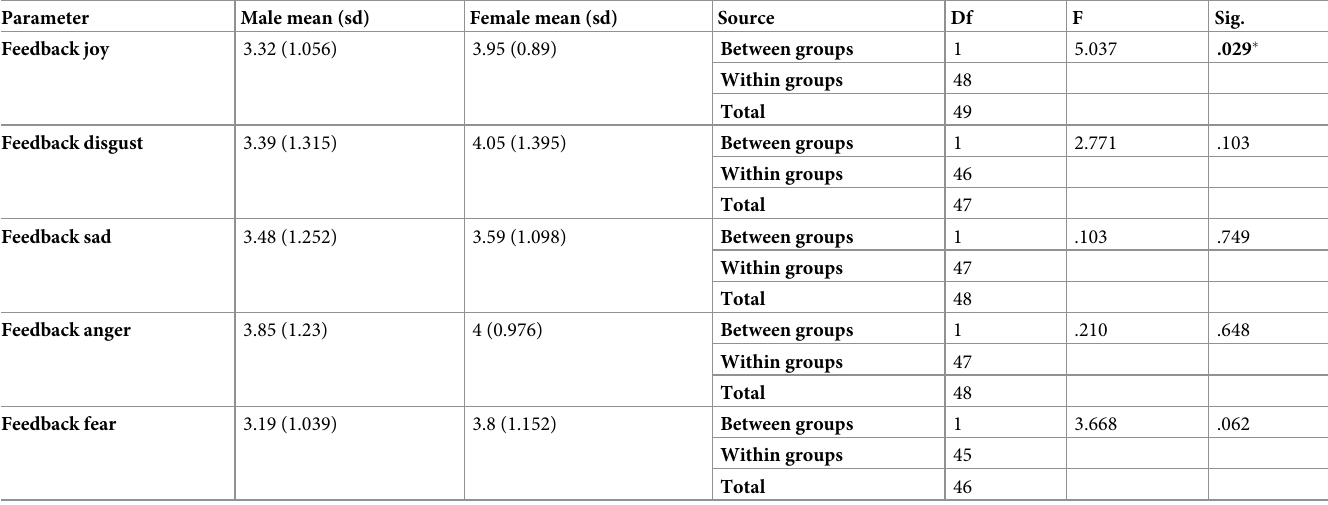
Table 9. ANOVA for emotion feedback form rating for all emotions by males and females.